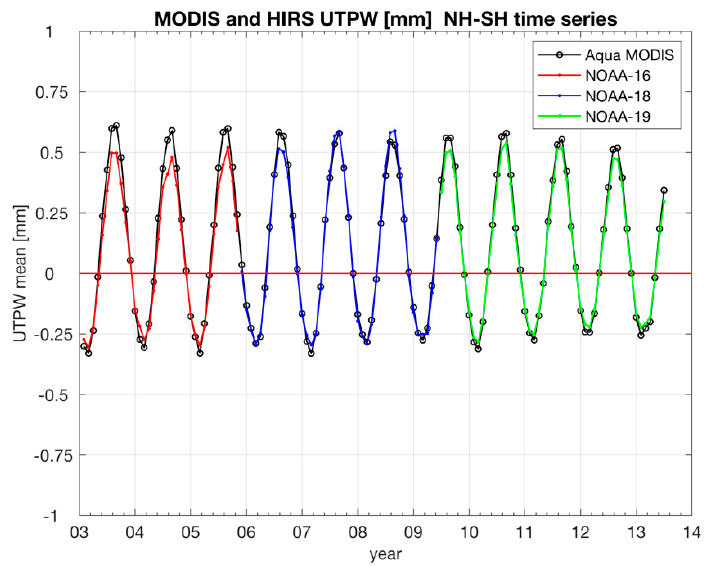
Figure 8. HIRS and MODIS northern (60° N to Equator) minus southern (Equator to 60° S) hemispheric mean UTPW by month from 2003 to 2014.